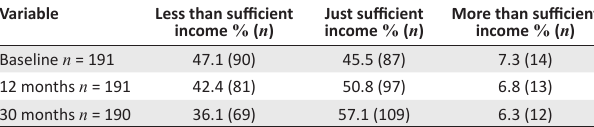
TABLE 5: Family income over